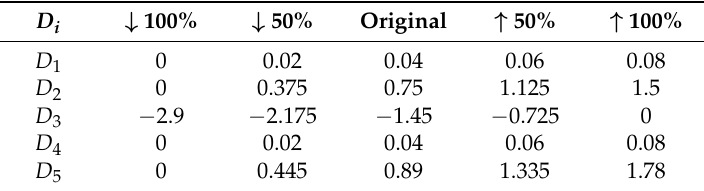
Table 5. The researched JC fracture parameters for Inconel 718.